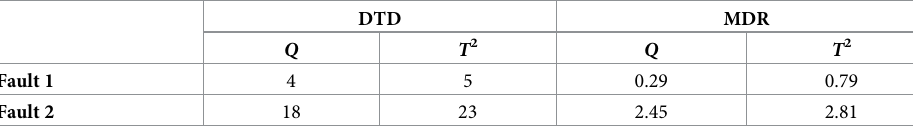
Table 5. DTD and MDR for MWDPCA applied on TET